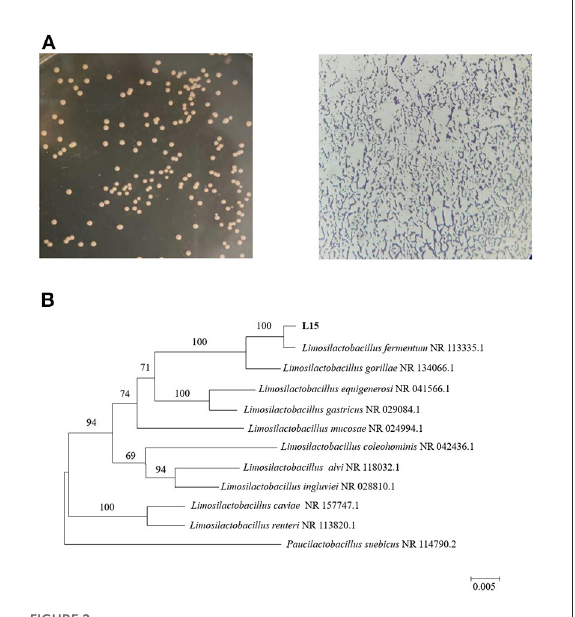
FIGURE2 Identification of strain L15. (A) Morphology of screened strain L15 on MRS plate and under the microscope. (B) Phylogenetic tree based on 16S rRNA gene sequences of strain L15. The evolutionary history was inferred using the Neighbor-Joining method, scale bar represents 0.01 nucleotide substitution per